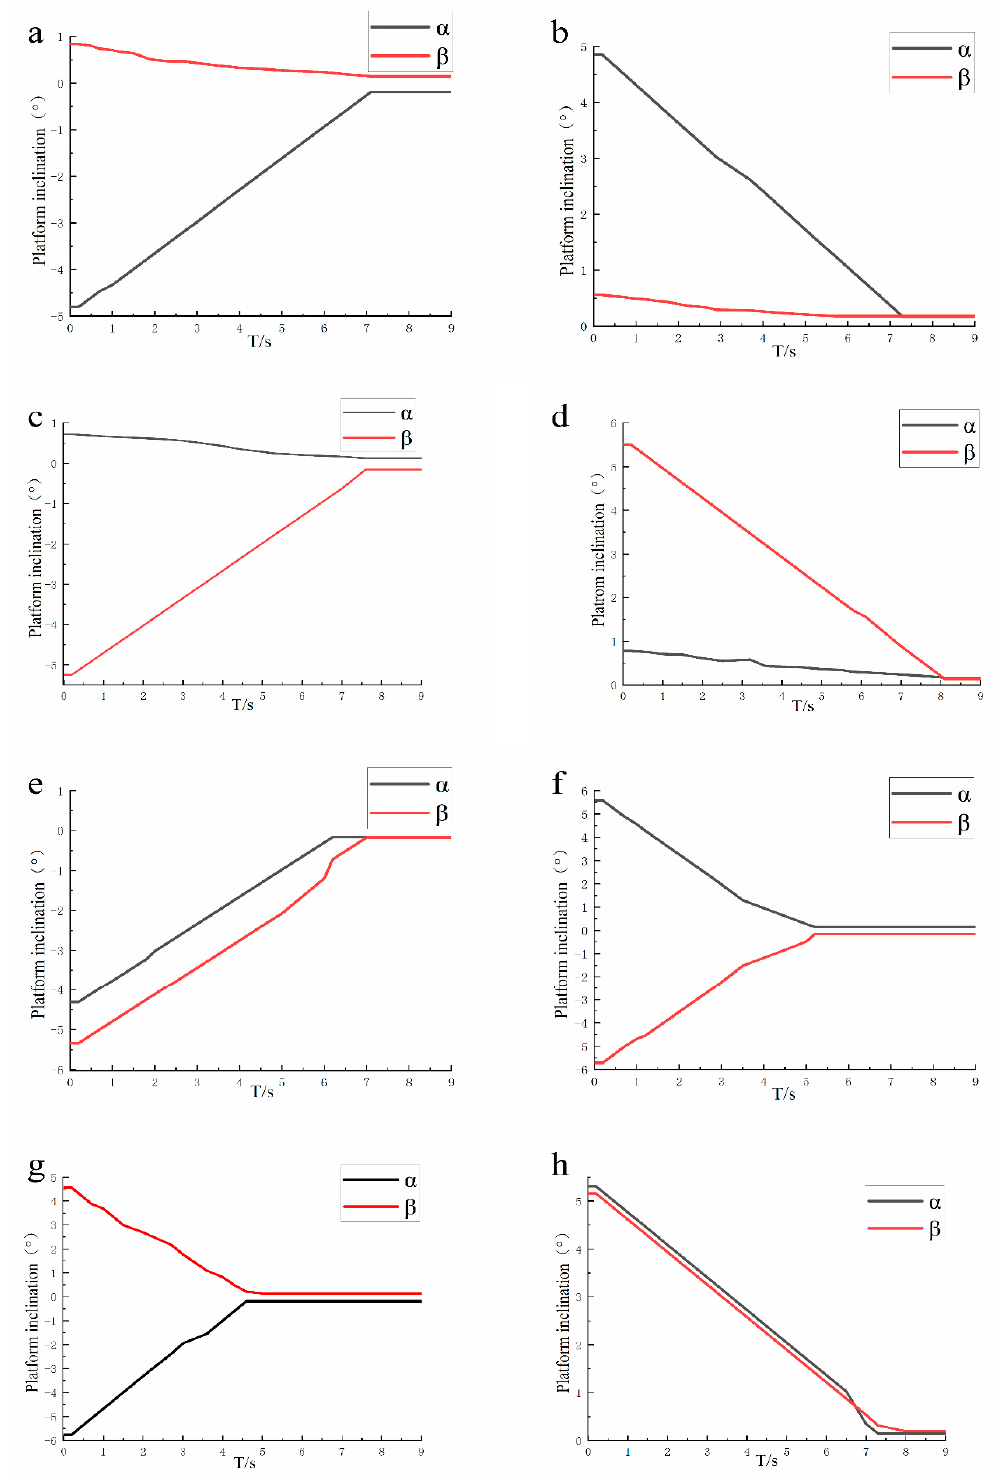
Figure 10. Automatic levelling results under eight tilting states. ( a ) Front lowest, ( b ) Rear lowest, ( c ) Left lowest, ( d ) Right lowest, ( e ) Left front lowest, ( f ) Left rear lowest, ( g ) Right front lowest, ( h ) Right rear lowest.